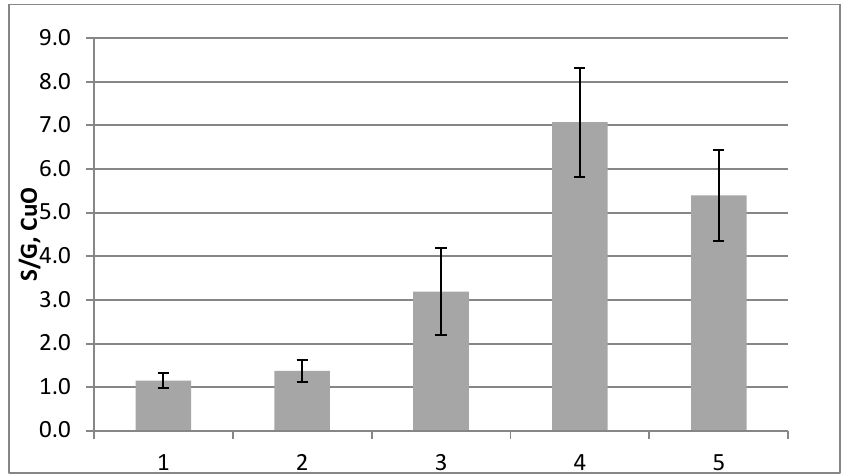
Figure 4. Total amounts per g of dry weight of the syringyl (S)-, the guaiacyl (G)-, p -hydroxyphenyls (H)- and hydroxycinnamyls (C)-groups in the different fractions obtained using the CuO method. ( A ) The S-group contains syringaldehyde, acetosyringone and syringic acid; ( B ) the G-group vanillin, acetovanillone and vanillic acid; ( C ) the P-group 4-hydroxybenzaldehyde, 4-hydroxyacetophenone and 4-hydroxybenzoic acid; and ( D ) the C-group p -coumaric acid and ferulic acid. 1, Cork cambium; 2, non-conductive phloem; 3, combined conductive phloem, cambium and differentiating xylem; 4, lignified xylem; 5, previous year’s xylem.